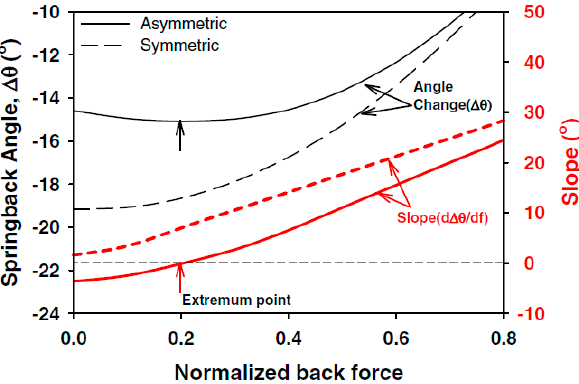
Figure 13. Comparison of calculated springback angles using symmetric and asymmetric models ( π R θΔ = − − , R and r are the curvature radius before and after springback, d (1 ) 2 r normalized back force) [104]. Reprinted with permission from Ref. [104]. Copyright 2009, Int. J. Plas- ticity.